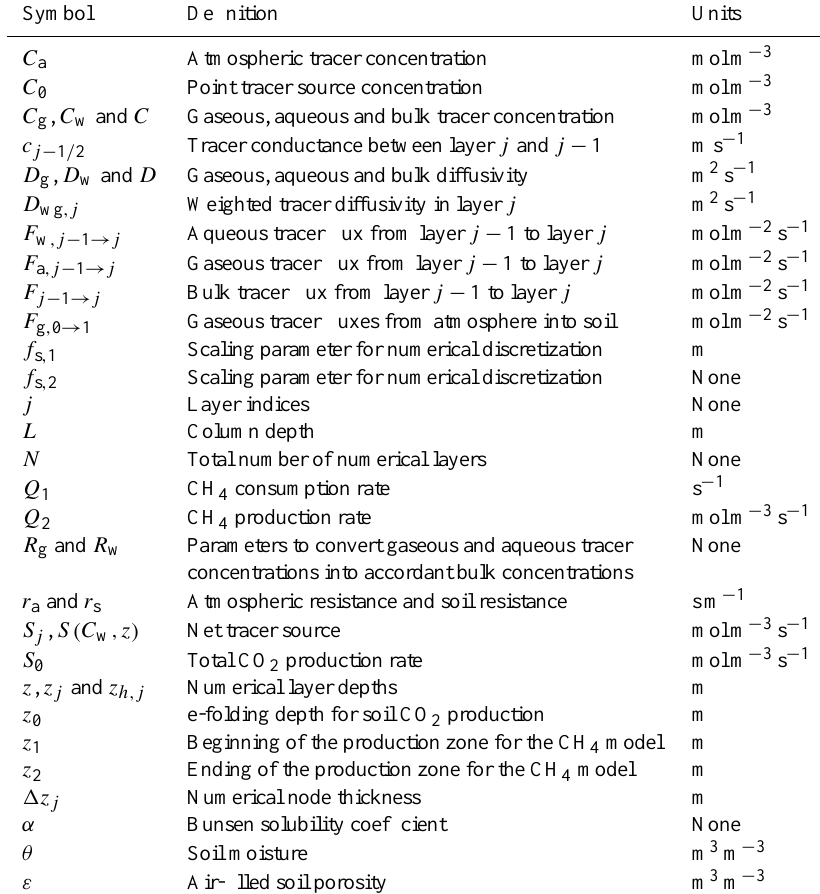
Table A1. Symbols used in paper, their definitions and corresponding